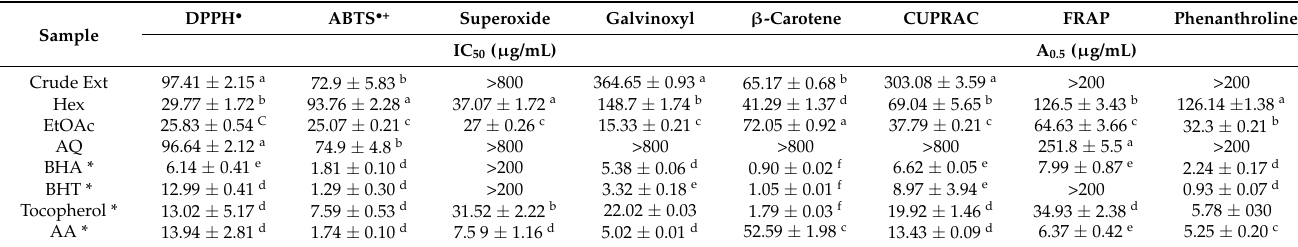
Table 3. Antioxidant activities of the hydroacetonic crude extract and of the purified fractions from S. vulgare